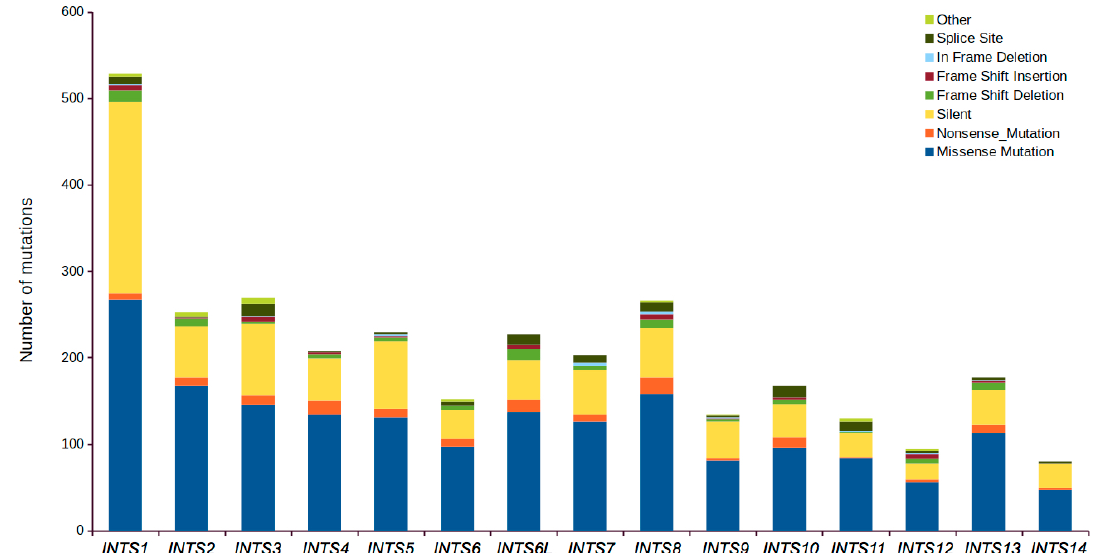
Figure 1. Stacked histograms showing the number of different classes of somatic mutations affecting INT genes as reported in the Mutation Annotation Files across all analyzed cancer entities.